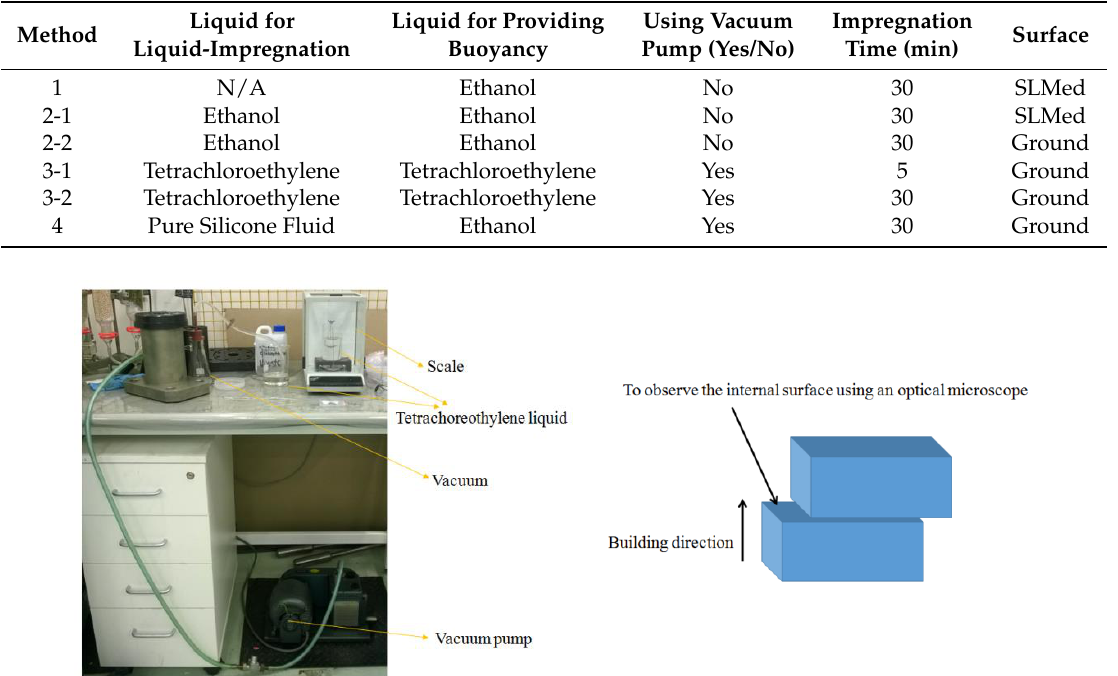
Table 3. Different procedures based on the Archimedes method.